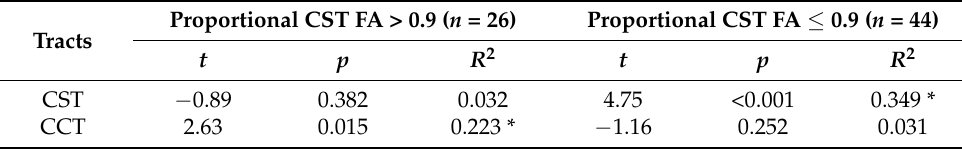
Table 3. Predictive values in subgroups divided by CST integrity.